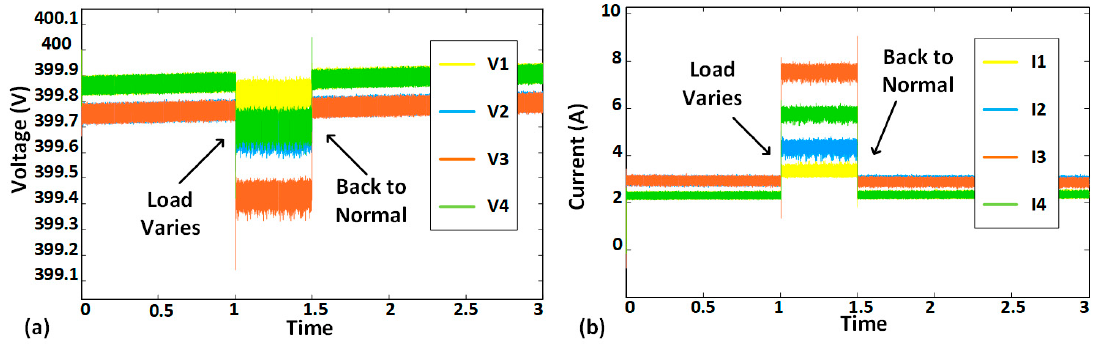
Figure 10. Load variation in the DC microgrid: ( a ) node voltage; ( b ) node current.